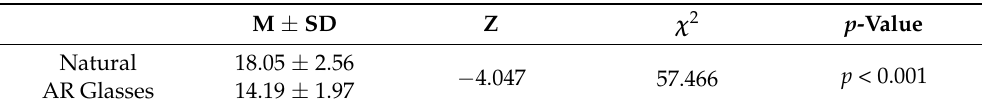
Table 3. Comparison of the blink rate in the natural environment and AR glasses environment